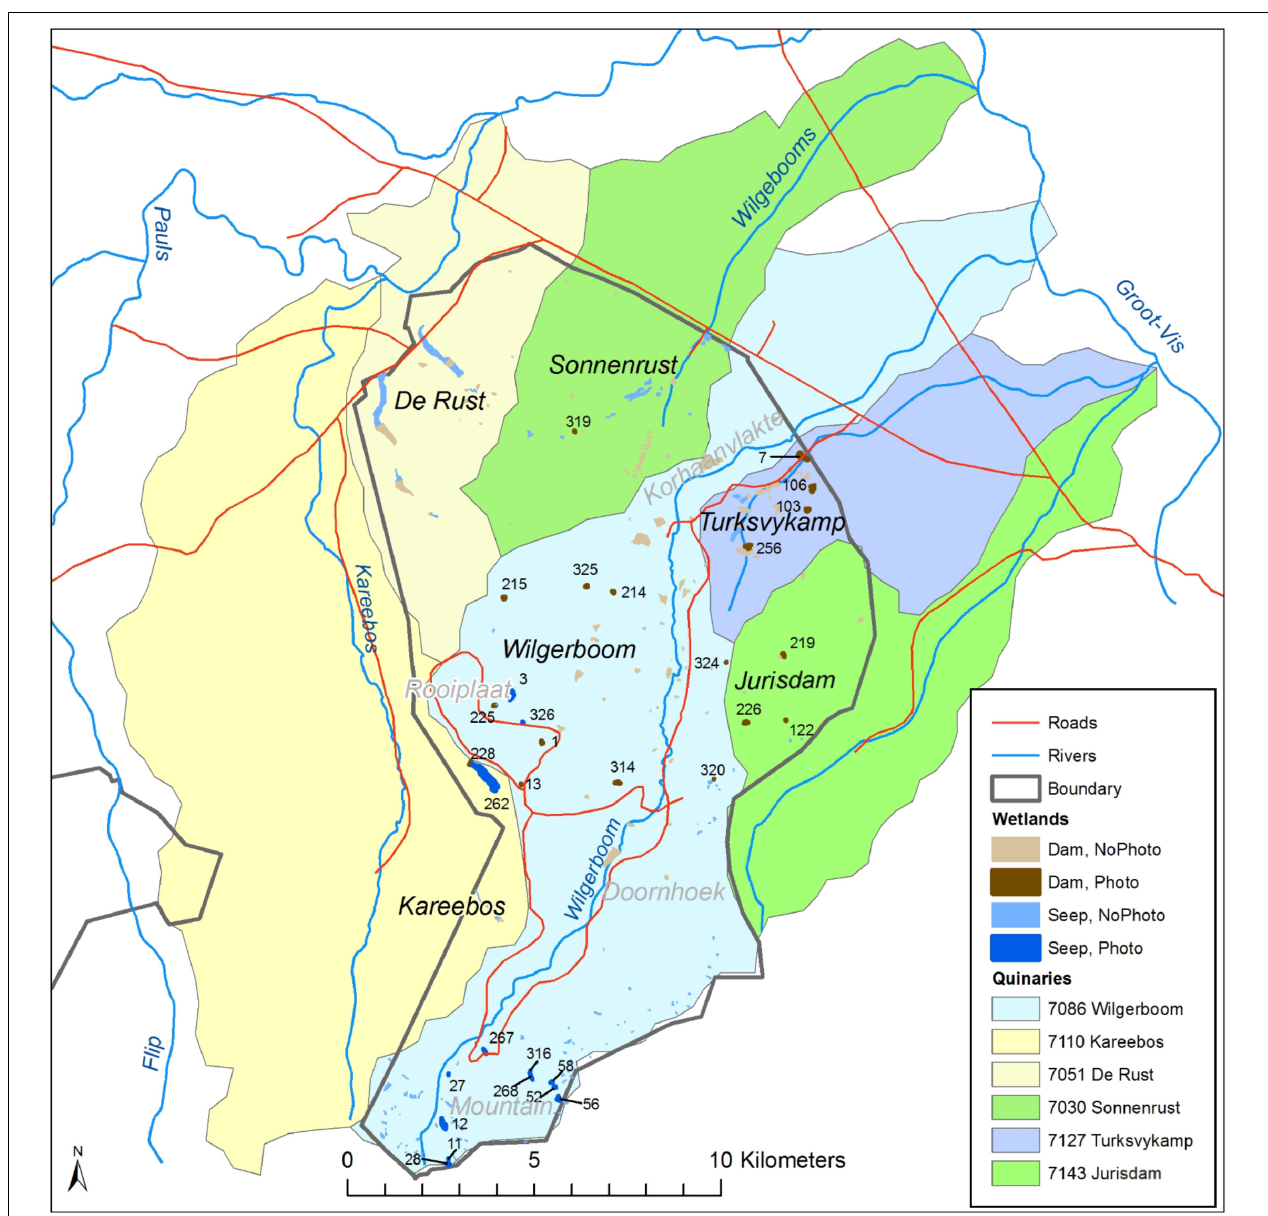
FIGURE 2 | Mountain Zebra National Park